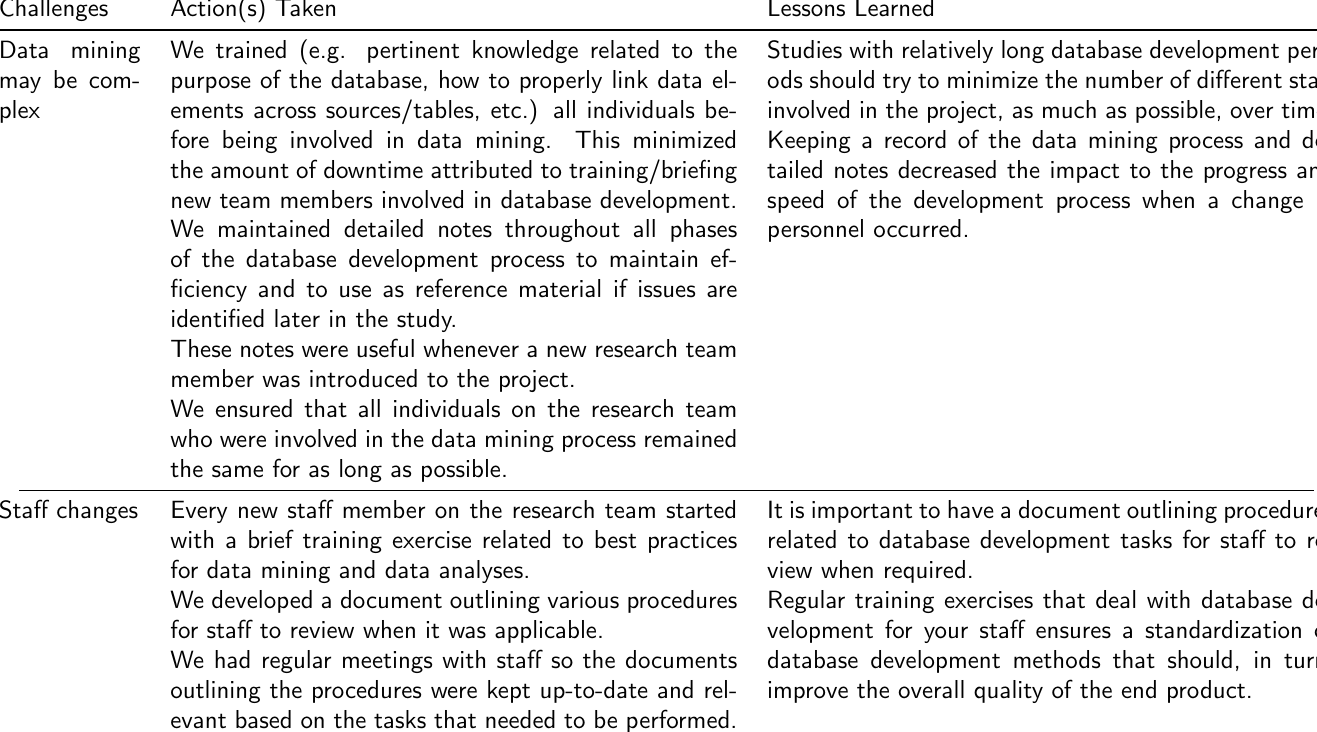
Table 2d: Action(s) taken and lessons learned for challenges that slow the progress of transforming data to information.